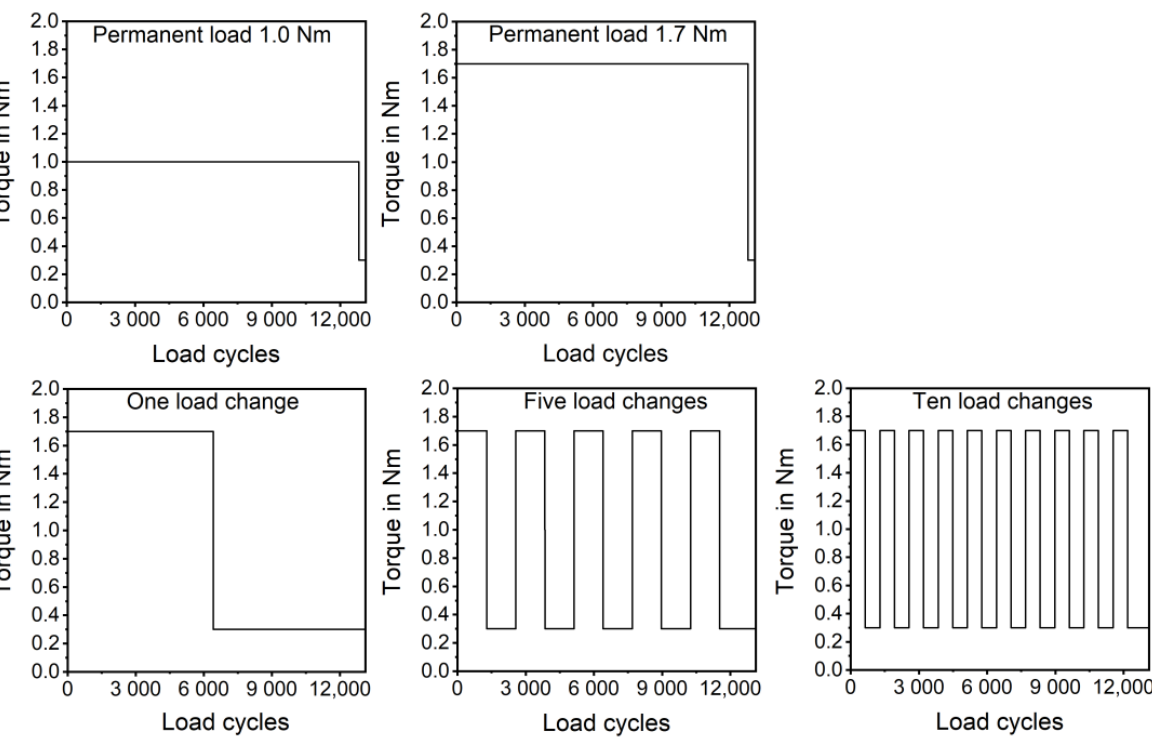
Figure 6. Torque settings used for the gear tests.